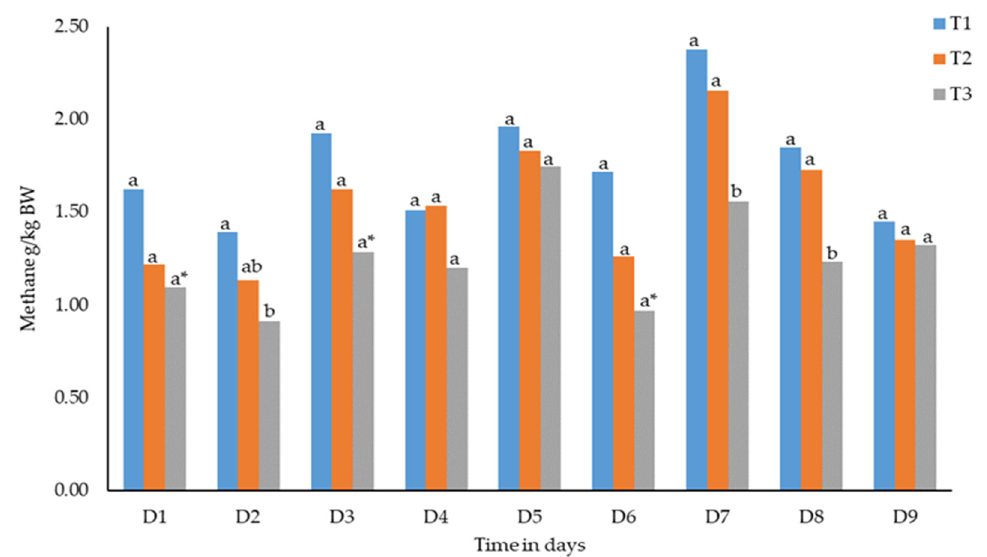
Figure 1. Effects of barley sprouts supplementation on daily methane emission potential of meat- master lambs. “a, b” letters within a day means different significantly at p ≤ 0.05 and “a*” denotes the trend at 0.05 < p ≤ 0.10.